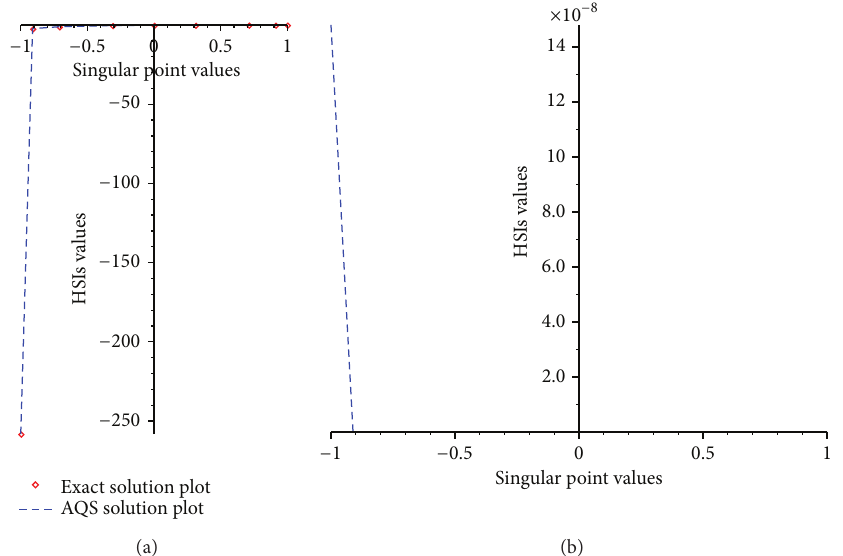
Figure 4: (a) Exact and AQS solutions when 𝑁 = 20 and ℎ(𝑡) = 1/(2 + 𝑡) and (b) absolute error between exact and AQS solution when 𝑁 = 20 and ℎ(𝑡) = 1/(2 + 𝑡) .